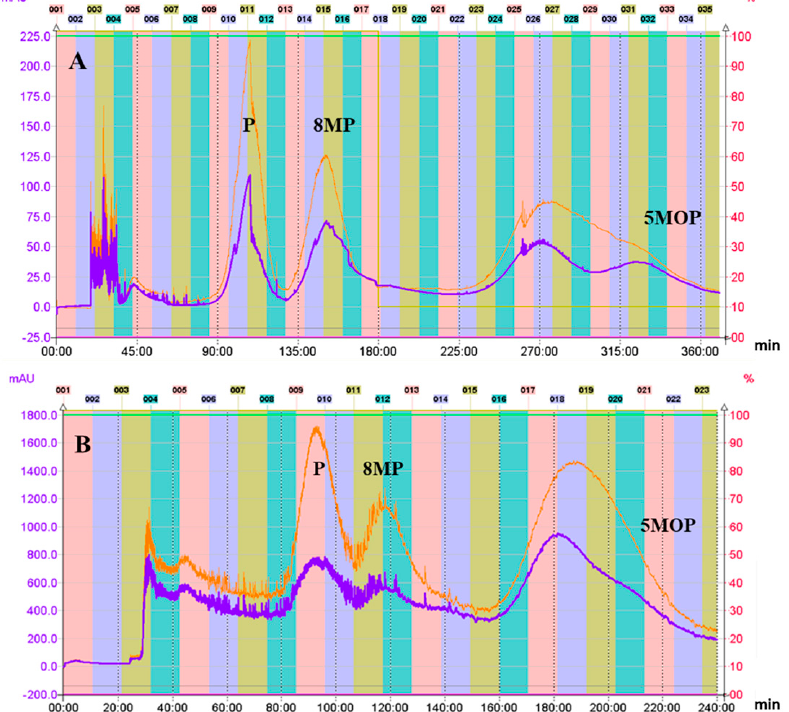
Figure 2. CPC chromatograms of the crude petroleum ether extract of Peucedanum tauricum fruits; solvent system: n Hp:E:M:W (5:2:5:2, v / v / v / v ) in the ascending mode of elution (stationary: aqueous phase; mobile: organic phase; flow rate: 3 mL/min; rotation speed: 1600 rpm; detection: 320 nm lower line; 254 nm higher line). Sample size of crude extract: 20 mg on the analytical scale ( A ) and